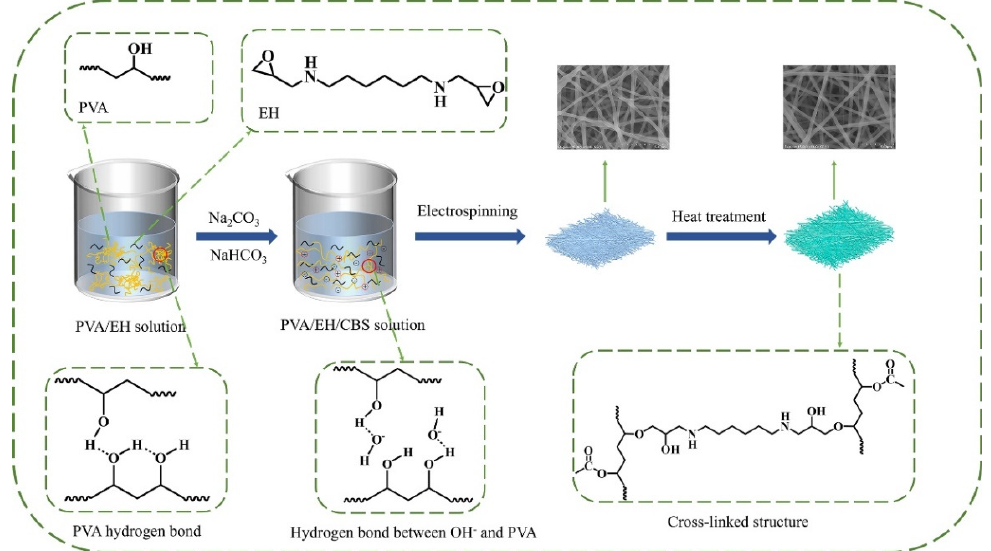
Figure 1. Schematic illustration of preparing PVA/EH/CBS nanofibers. PVA nanofibers without heat treatment dissolved in water immediately. After heating at 160 °C for 10 min, the morphology of PVA nanofibers did not change significantly, as shown in Figure 2a. After being immersed in water, these heated PVA nanofibers dissolved, lost the fibrous morphology and formed a dense film, as shown in Figure 2d. This is because there are a large number of hydrophilic hydroxyl groups (87.0–89.0%) on PVA molecule chains. Although the high temperature treatment could induce etherification reaction between hydroxyl groups, only a small percentage of them took part in the reaction since etherification is very hard to proceed with in the absence of catalysts [38]. The unreacted hydroxyl groups on the molecule chains made PVA nanofibers soluble in water.